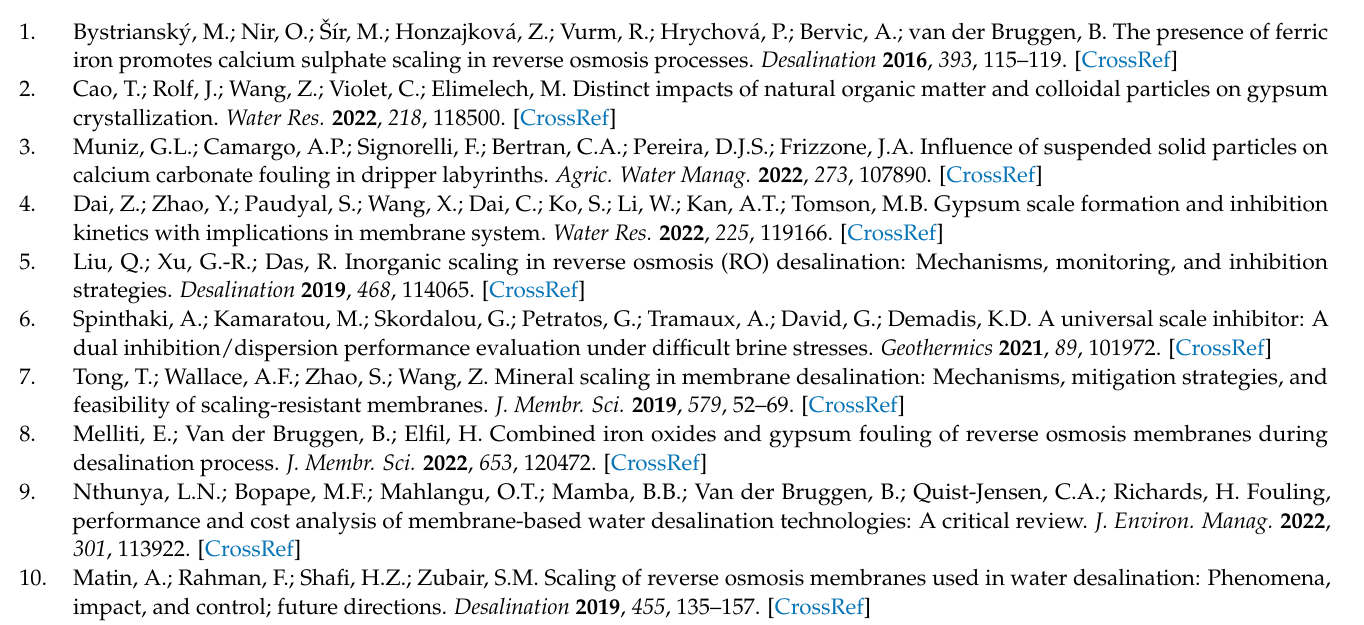
Figure A2. SEM images of mineral scale crystals formed on the RO membrane in the membrane monitoring system (MMS) during RO desalination of AD water showing different mineral crystal morphologies. Mineral crystals resembling “flattened” gypsum rosettes ( A – C ), and high mag. image of a “flattened” crystal rod or arm ( D ).